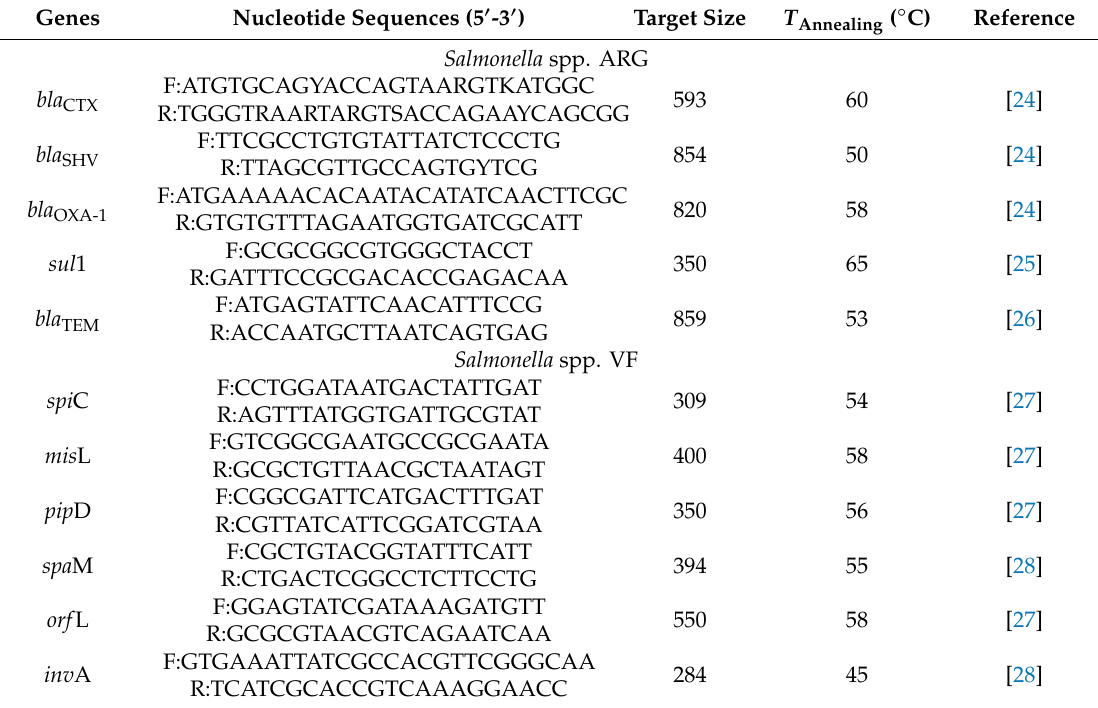
Table 1. Oligonucleotide primers in the PCR